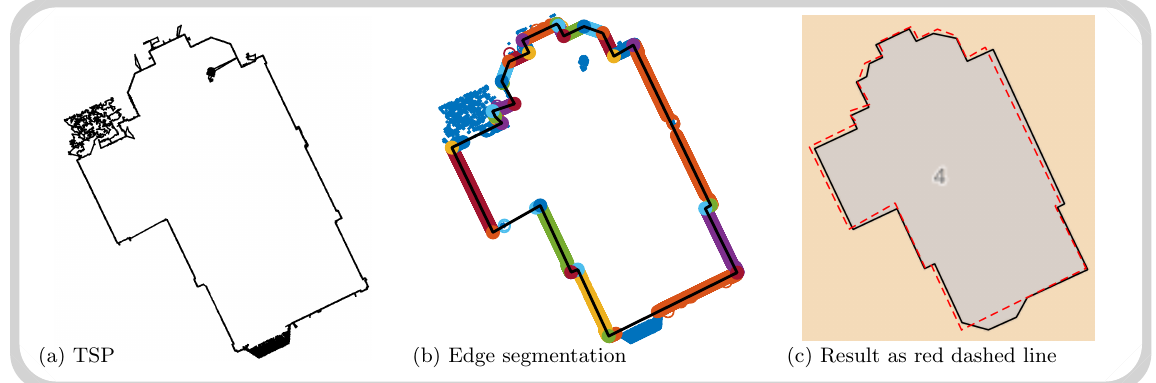
Figure 6: E STATE building: Outliers, i.e. points not belonging to facade surfaces, present in the TSP solution highly influence the quality of the extracted footprint. Our approach can although deliver a satisfactory result.